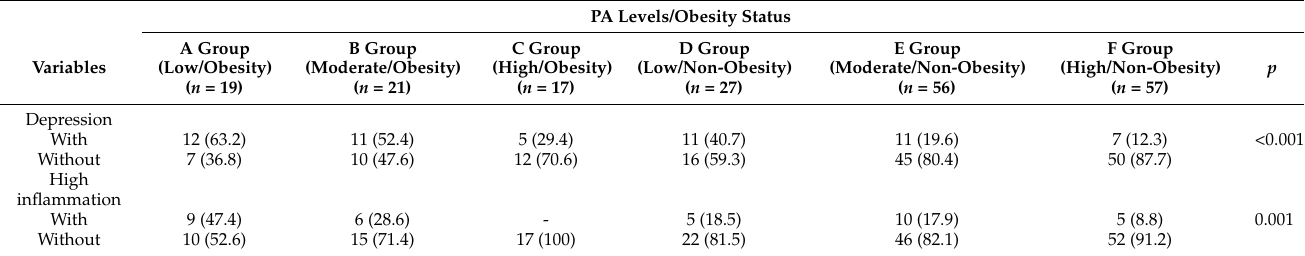
Table 2. Prevalence of depression and high inflammation for combined PA levels with obesity status 1,2 . PA Levels/Obesity